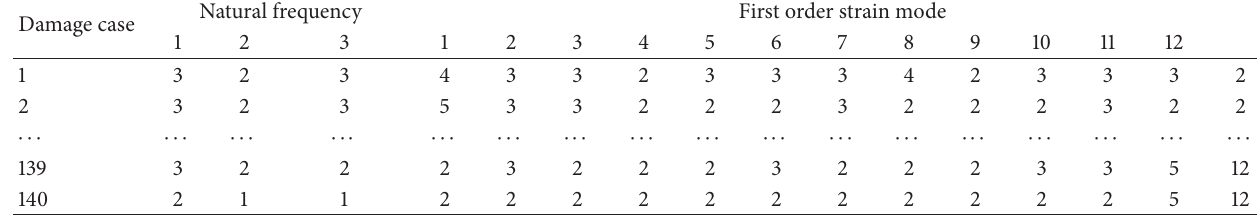
Table 7: Attribute set 1 rules generation for damage